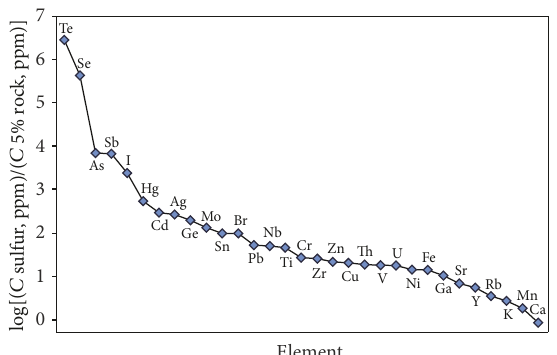
Figure 9: Logarithms of elemental ratios C (sulfur)/ C (5% rock), similar to enrichment factors (see details in